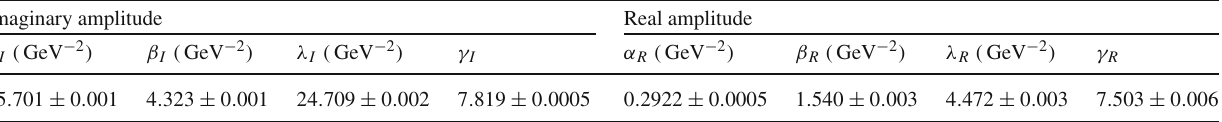
Table 1 Parameters of the amplitudes in the KFK model determined with the 428 points of Totem measurements at 13 TeV. The QCD quan- tity related to correlation function is a 2 = 2 . 1468 ± 0 . 0001 GeV − 2 = ( 1 . 4652 GeV − 1 ± 0 . 0002 ) 2 = ( 0 . 2891 ± 0 . 0002 fm ) 2 , where a is called correlation length. The quantities γ I and γ R characteristic of the